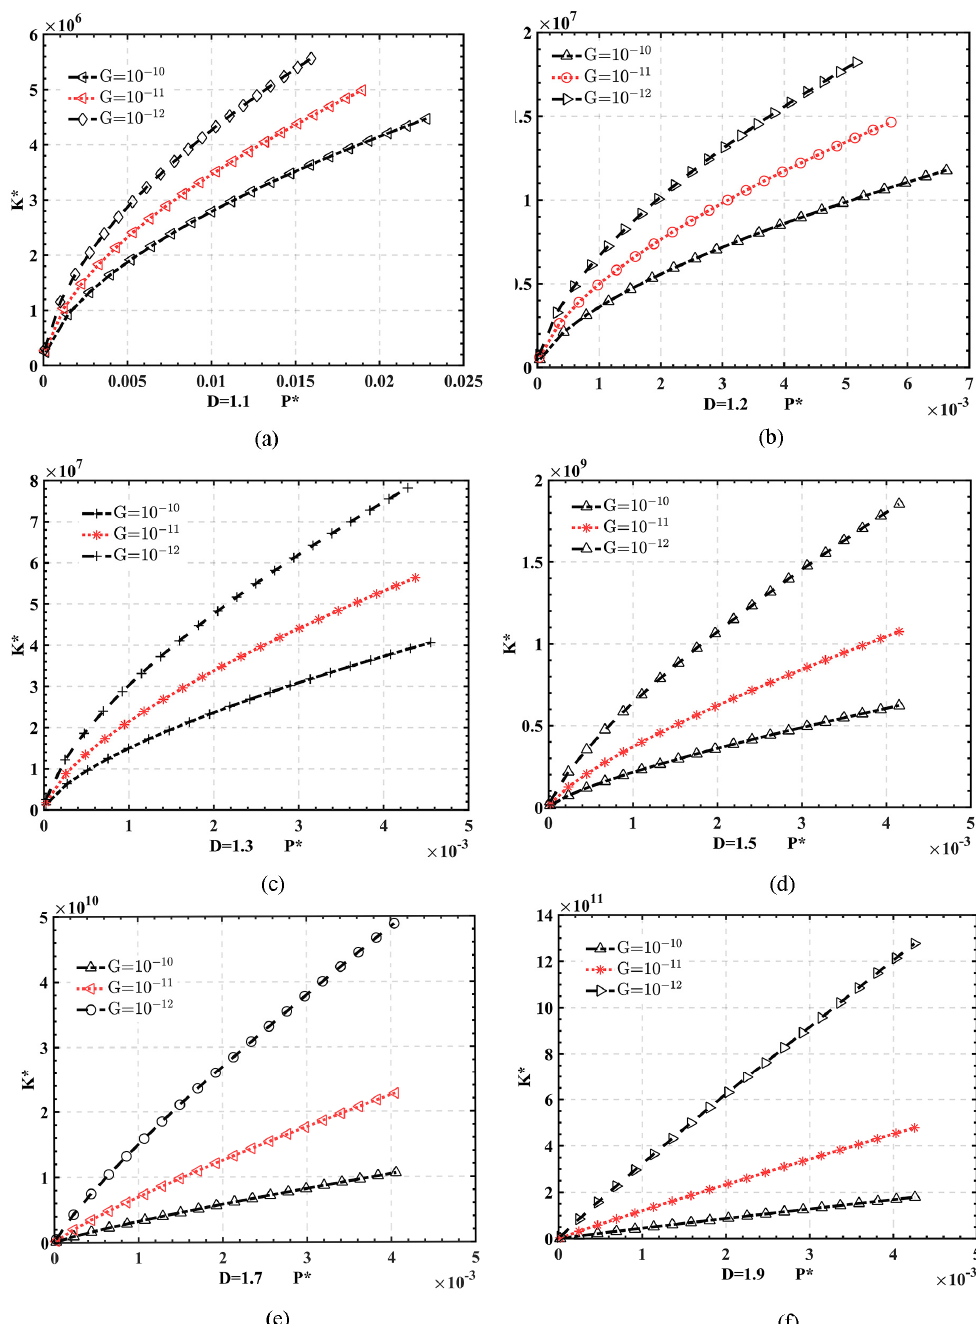
Figure 5. Influence of length scale parameter G* on P ∗ -K* curve with ∆ T ∗ = 300; ( a ) D = 1.1 ( b ) D = 1.2 ( c ) D = 1.3 ( d ) D = 1.5 ( e ) D = 1.7 ( f ) D = 1.9.